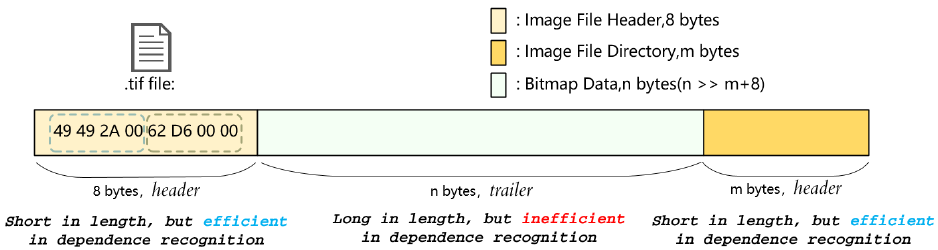
Figure 5. Example of inefficient byte-by-byte analysis on the trailer